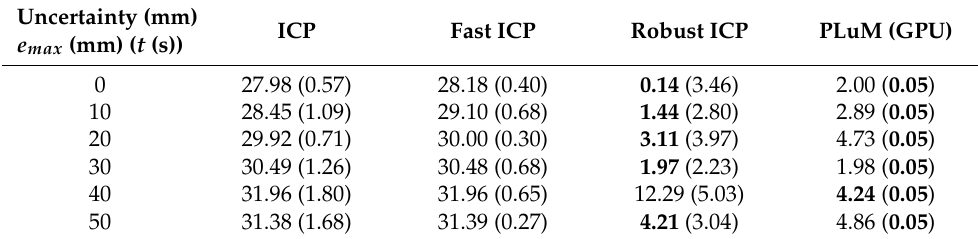
Figure 14. ( a , c ) Show example registration results for the problem in Figure 7a with 10 mm and 30 mm measurement uncertainty, respectively. The effect of adding sensor measurement uncertainty on the maximum vertex error is displayed in ( b ), and the corresponding execution times in ( d ). Table 7. The maximum vertex error and execution time for each method. The best results are displayed in